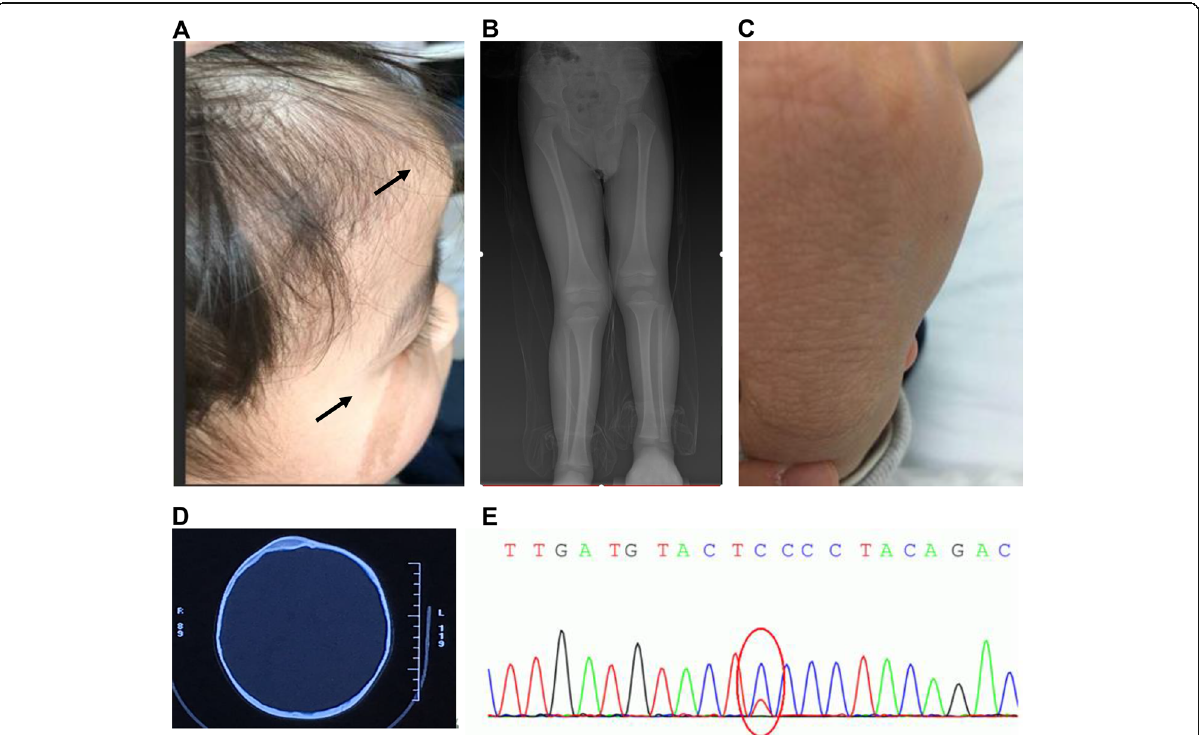
Fig. 1 Representative images of the patient. a Milk coffee spots on the right facial skin (arrow) and right frontal bone bulging (arrow). b X-ray detection: the right lower extremity was longer than the left one. c Nodular thickening skin on right hand back. d Head CT detection: thickening of the local diploic space on the right side of the frontal bone, showing a glass-like density. e Disease gene screening of the lesion samples form the milk coffee spots, and nodular thickening skin at hands and feet. There was a heterozygous point mutation 49G > A (p.Glu17Lys) in the exon region of the AKT1